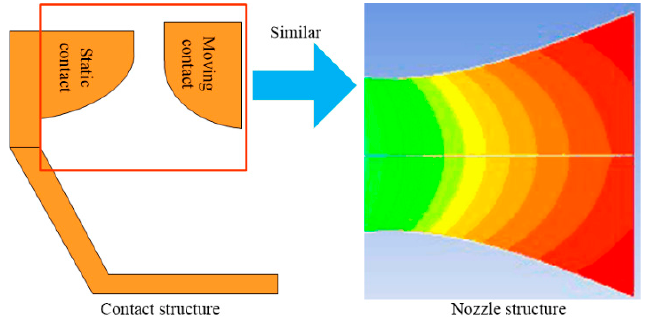
Figure 15. Improved contact structure for DC arcs.